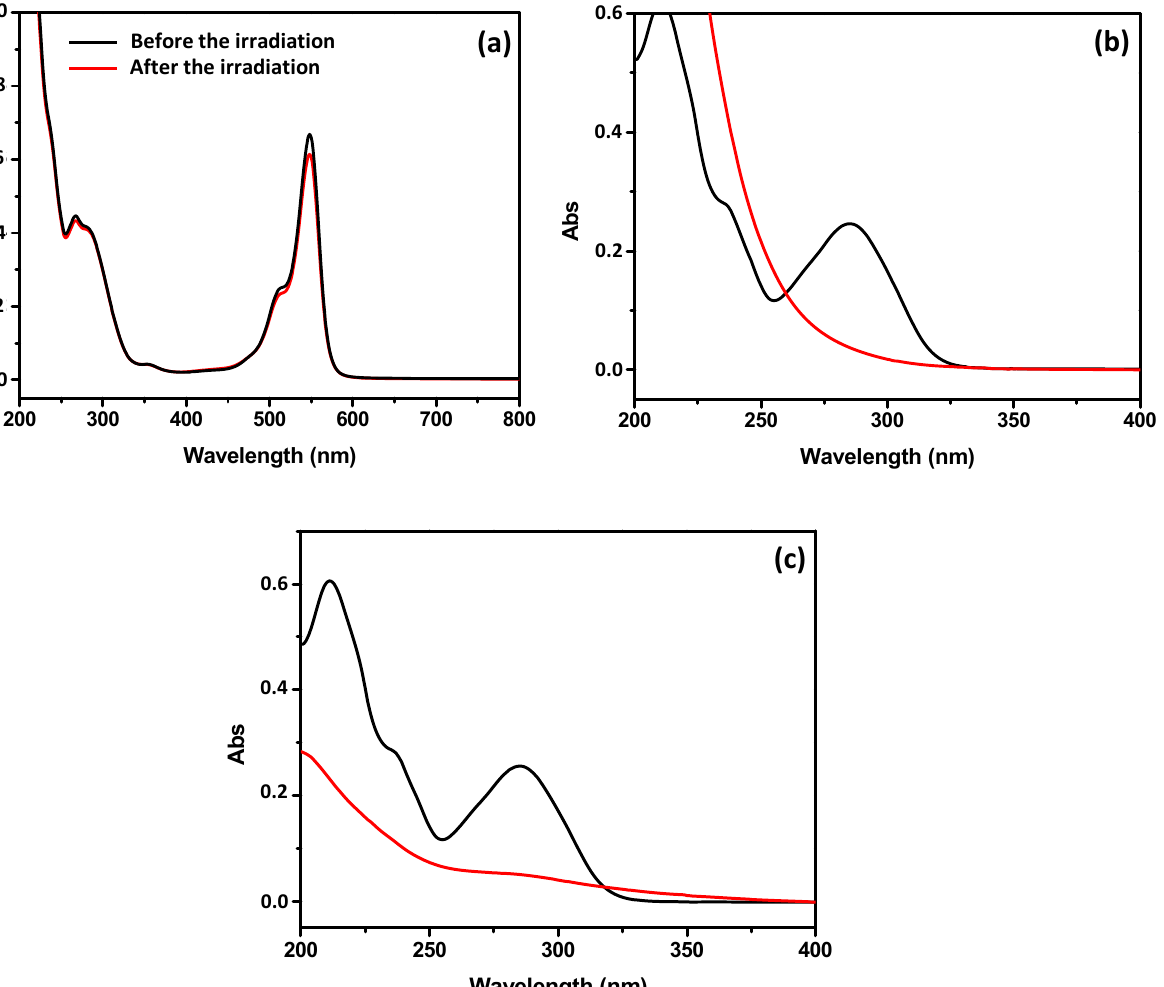
Figure 8. CBZ spectra before and after 1 h ‐ long UV irradiation at 254 nm in the presence of ( a ) 10 − 5 M Rose Bengal, ( b ) 10 − 2 M hydrogen peroxide, and ( c ) 0.67 g/L of titanium dioxide.